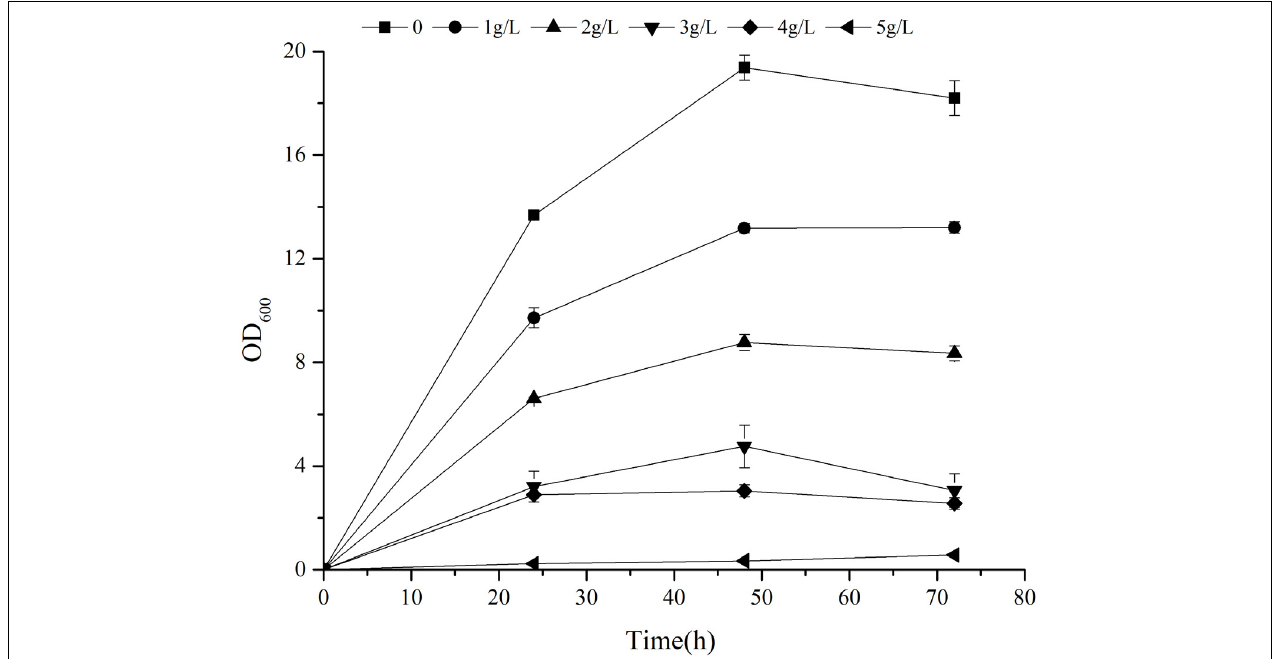
FIGURE 5 | The effect of exogenous 2-PE on the growth of Z. rouxii M2013310.